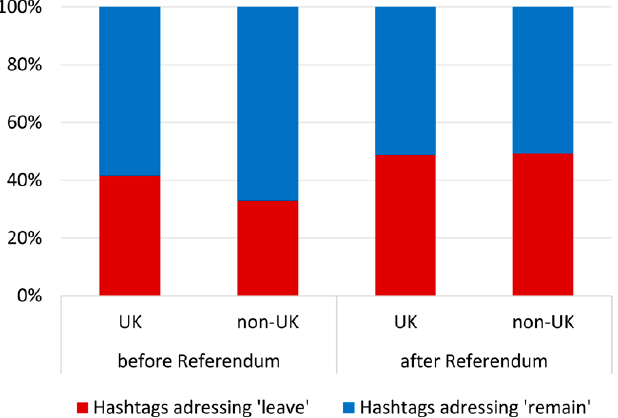
Figure 4. Percentages of the leave - and remain -related hashtags within and outside the